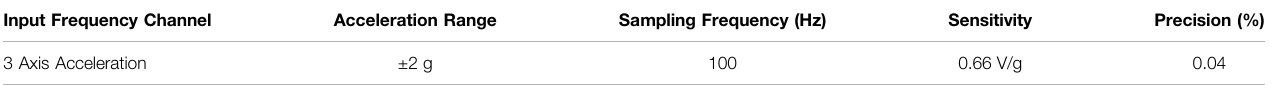
TABLE 1 | Xnode performance parameters.